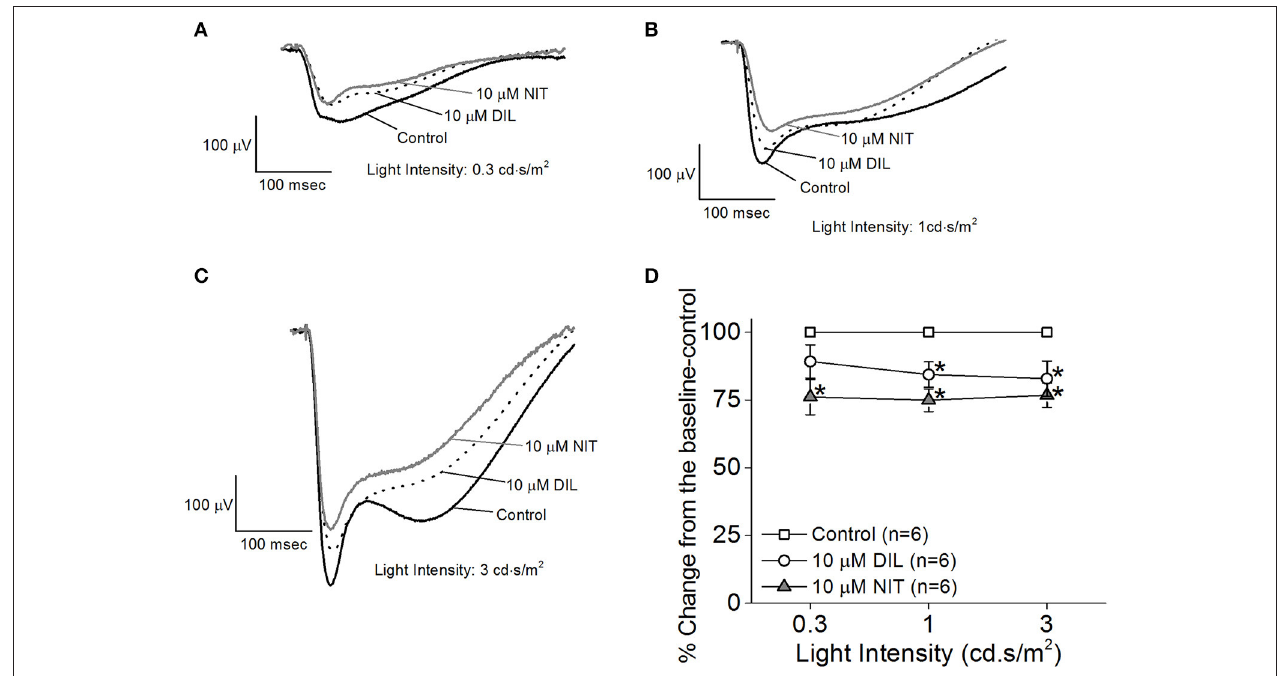
FIGURE 3 | Differential contributions of LTCCs in ex vivo ERG a-wave responses. Mice were dark adapted for at least 3h, and the retinas were excised and placed in an ex vivo ERG recording chamber. The ERG a-wave (photoreceptor) responses were isolated with a perfusion solution containing 2mM L-glutamate and 10 µ M DL-AP-4 and an electrode solution containing 2mM L-glutamate and 10mM BaCl 2 to block the higher order of retinal photo-responses. The photoreceptor light responses were recorded under 3 different light intensities: 0.3, 1, and 3 cd · s/m 2 . The ERG recordings were first done with normal perfusion buffer (Control), followed by perfusion with 10 µ M DIL, then perfusion with 10 µ M NIT. (A–C) Representative ERG a-waves recorded in different solutions (control, 10 µ M DIL, and 10 µ M NIT) are shown, under light intensities of 0.3, 1, and 3 cd · s/m 2 , respectively. (D) Perfusion with 10 µ M DIL and 10 µ M NIT for 10min each decreased ERG a-wave amplitudes. The asterisk (*) indicates that the 10 µ M DIL or 10 µ M NIT group is significantly different from the control. * p < 0.05.